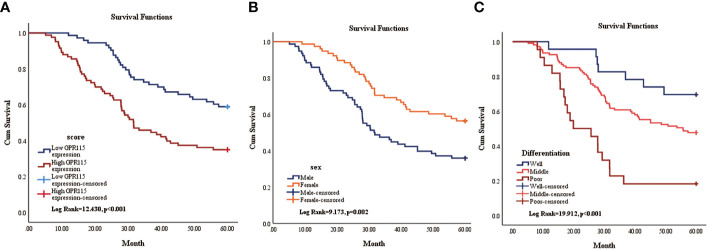
Kaplan-Meier survival curve of overall survival of LUAD patients. (A) The relationship of GPR115 expression and overall survival. Blue line indicated low GPR115 expression. Red line indicated high GPR115 expression. (B) The relationship between sex and OS of LUAD patients. Orange line indicated female and blue line meant male. (C) The relationship of differentiation and OS. Blue line, orange line and red line indicated well, middle and poor differentiation, respectively.